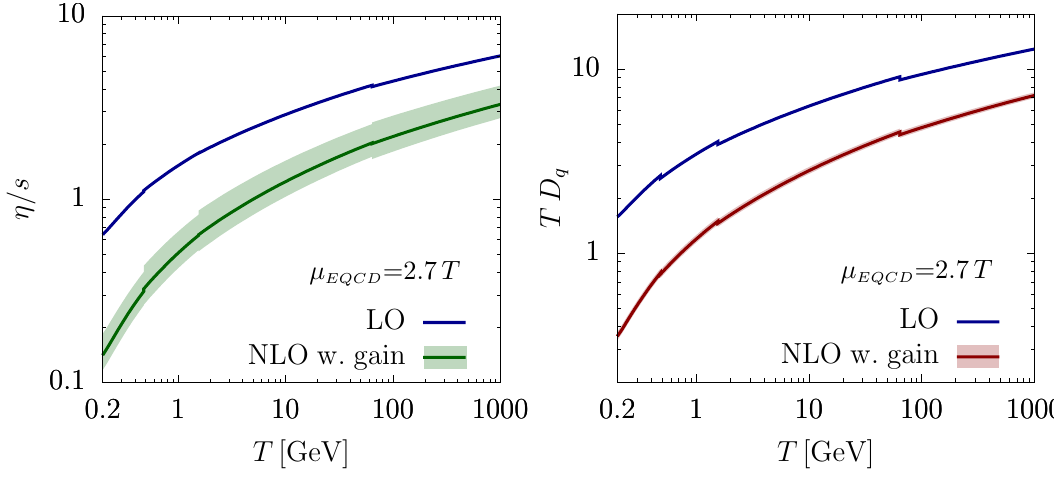
Figure 9 . (a) The QCD shear viscosity to entropy density ratio (cid:17)=s , and (b) di(cid:11)usion coe(cid:14)cient D q as a function of T . All curves in this plot are obtained using the e(cid:11)ective EQCD coupling with (cid:22) EQCD = 2 : 7 T . The uncertainty due to the gain terms which are estimated (and not computed) is shown by the shaded green and red bands respectively. This uncertainty estimate is described in (cid:12)gure